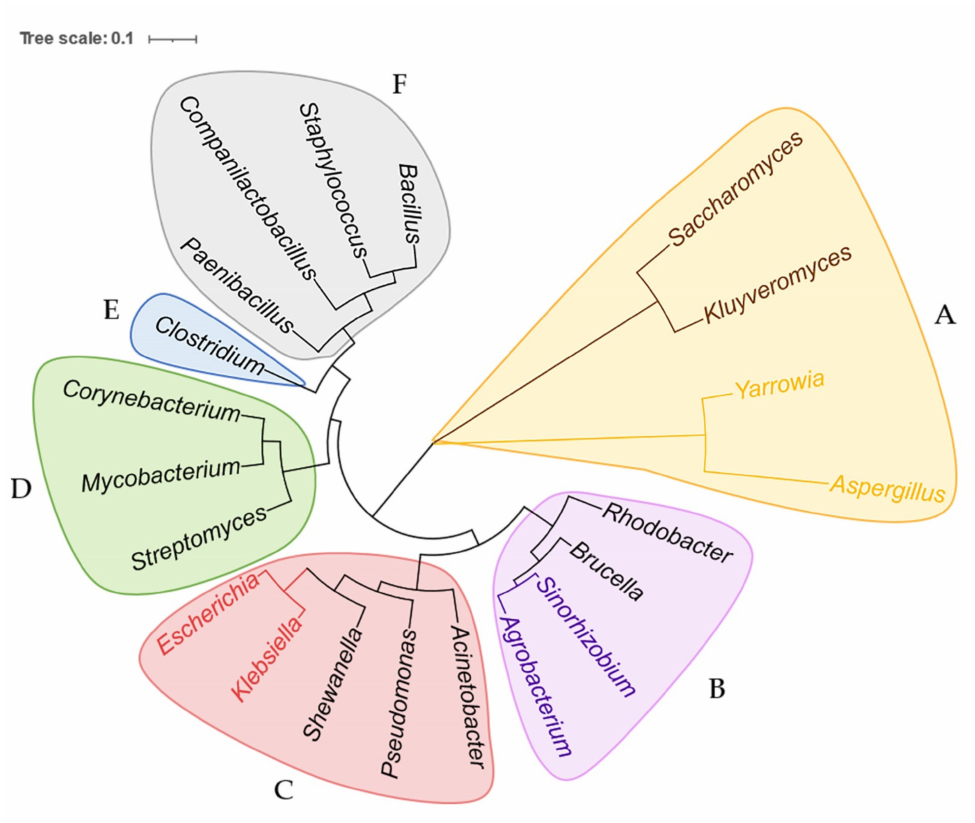
Figure 2. Phylogenetic tree of all microbes that have been researched by BEs, based on small-subunit rRNA sequences and constructed using the maximum-likelihood estimation. The phylogenetic tree includes 21 genera and six classes which are shadowed in different colors. ( A ) Microbes belong to the kingdom Fungi, phylum Ascomycota, and class Saccharomycetes. Saccharomyces and Kluyveromyces belong to the same family, Saccharomycetaceae, highlighted in brown. Yarrowia and Aspergillus belong to the same family, Dipodascaceae, highlighted in yellow. ( B ) Microbes belong to the kingdom Bacteria, phylum Proteobacteria, and class Alphaproteobacteria. Rhodobacter and Brucella belong to the family Rhodobacteraceae and Rhizobiaceae, respectively. Agrobacterium and Sinorhizobium belong to the same family, Brucellaceae, highlighted in purple. ( C ) Microbes belong to the kingdom Bacteria, phylum Proteobacteria, and class Gammaproteobacteria. Pseudomonas , Acinetobacter ,